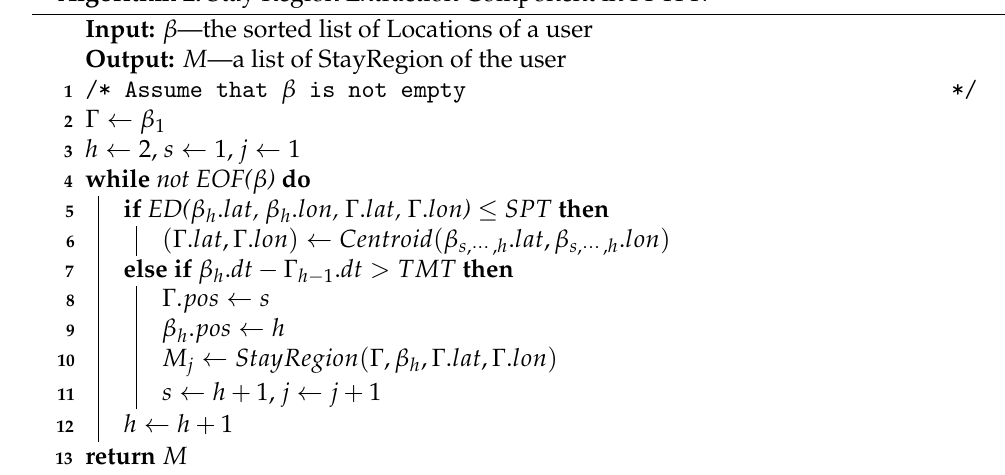
Algorithm 2: Stay Region Extraction Component in PPTPF.